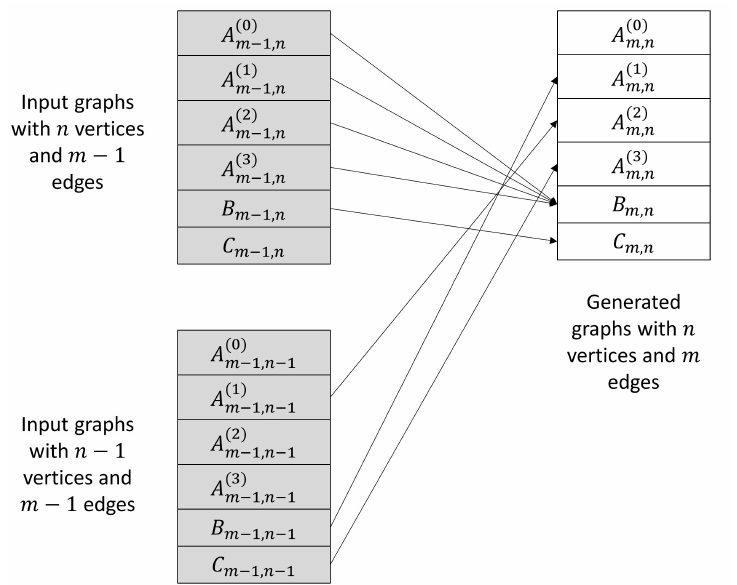
Figure 15. Graph generation